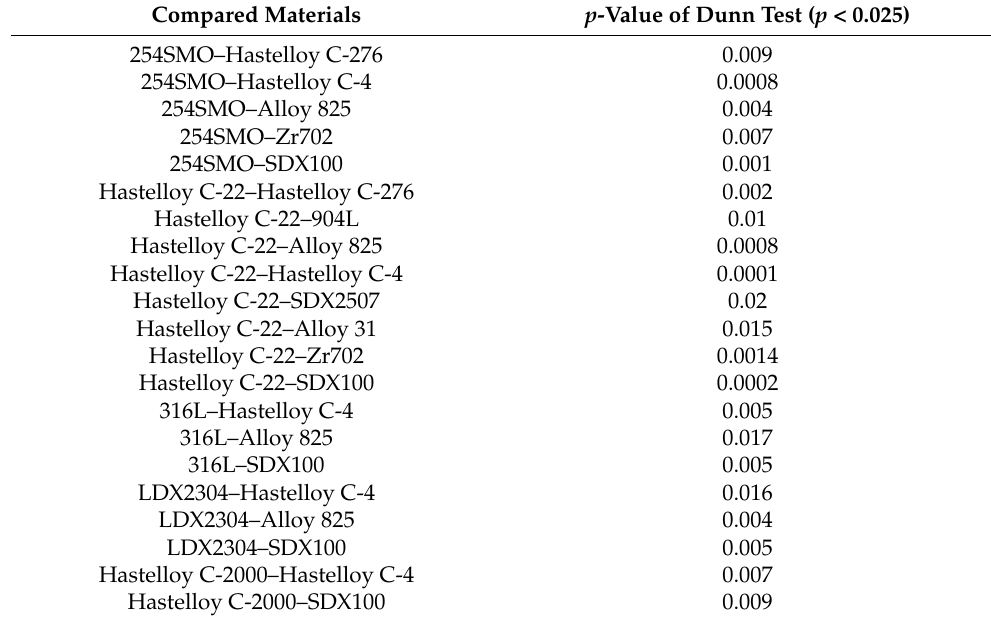
Table 3. Results of the Dunn test for saturated Ca(OH) 2 with a high chloride content. Compared Materials p -Value of Dunn Test ( p <